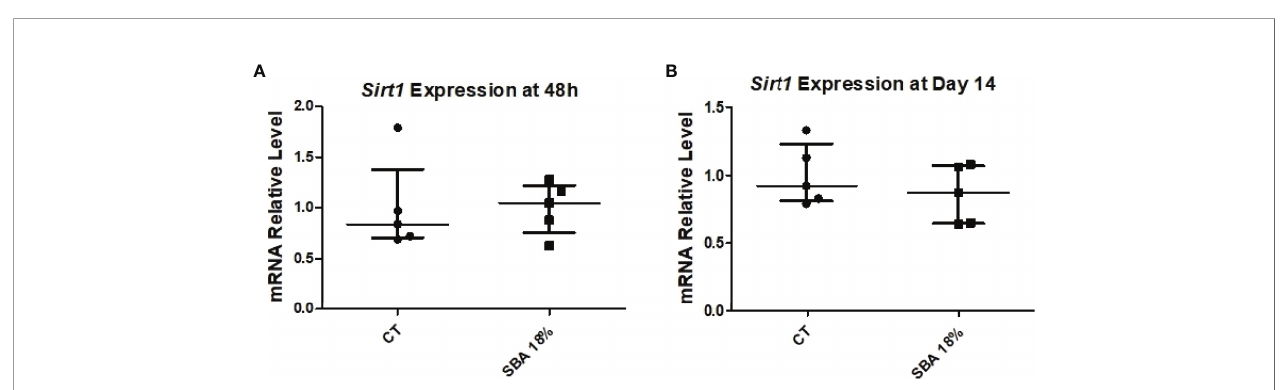
FIGURE 11 | 4-week SBA protocol induced no change in Sirt1 expression. (A, B) Relative mRNA expression level of sirtuin type 1 ( Sirt1 ) in CT and SBA groups (18%), cells were cultured for 48 hours in standard growth media and for 14 days were exposed to co-differentiation media, respectively. Data represent median and interquartile range; n = 5. Statistical analysis was performed using Mann – Whitney ’ s test.